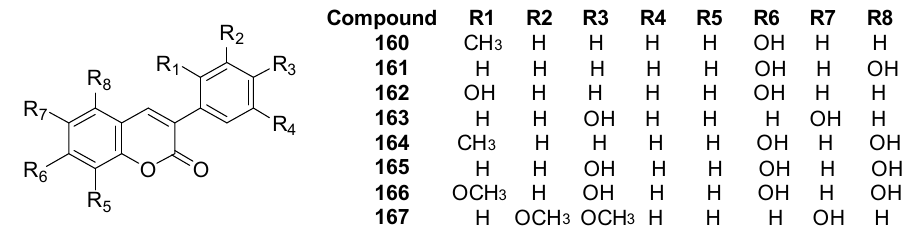
Figure 55. Chemical structure of compounds 160–167 .